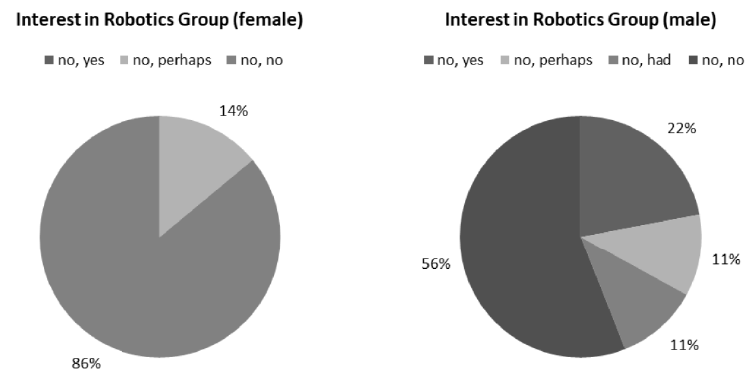
Fig. 8. Pile up cubes: Interest in robotics group. The first yes or no refers to current participa- tion in the robotics group and the second if they would